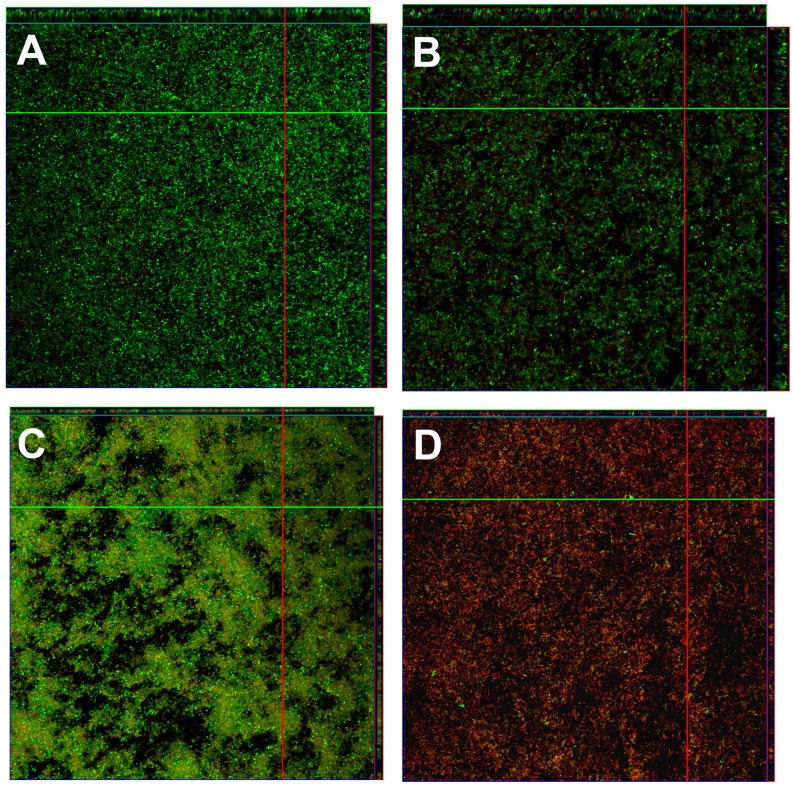
Twenty-four hours old E. faecalis ATCC 29212 biofilms were treated with (A) control biofilm with no treatment, (B) 512 mg/L penicillin alone, (C) 400 U/ml nisin alone, and (D) the combination of 512 mg/L penicillin and 400 U/ml nisin for 12 h.Their 3-dimensional images were scanned along the Z axis at different positions from bottom to top.